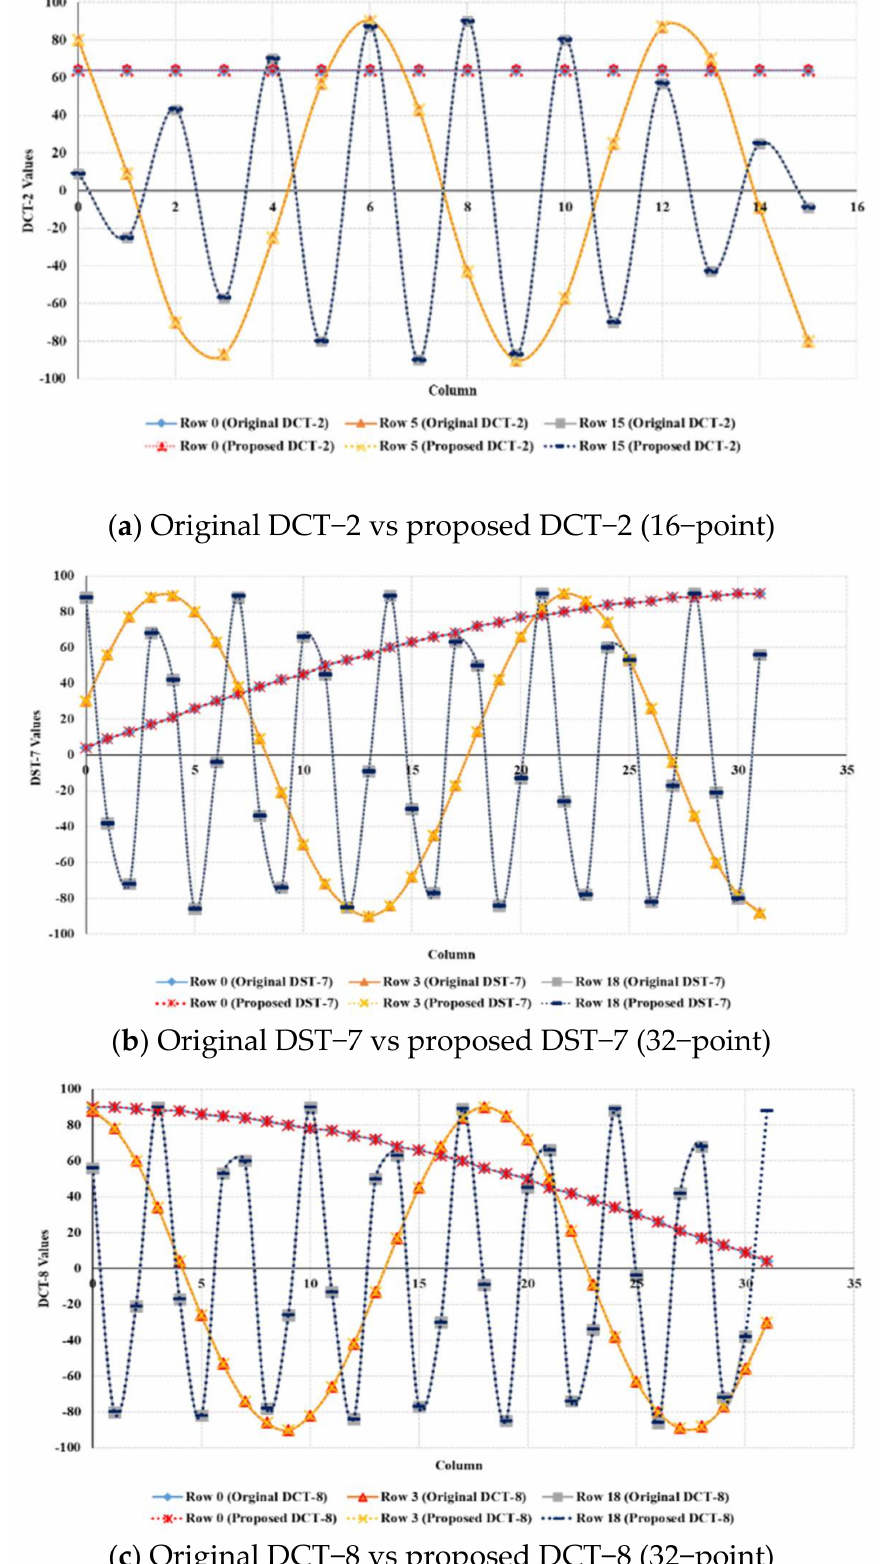
Figure 19. Comparison between the proposed and original transform